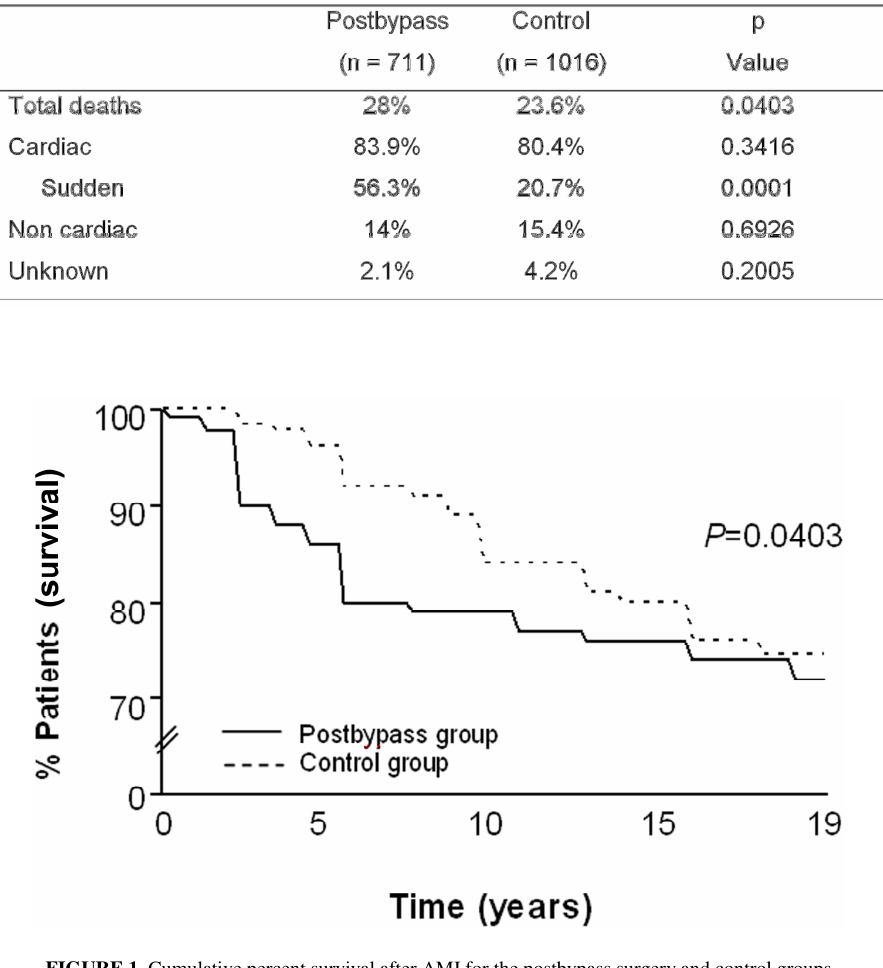
FIGURE 1. Cumulative percent survival after AMI for the postbypass surgery and control